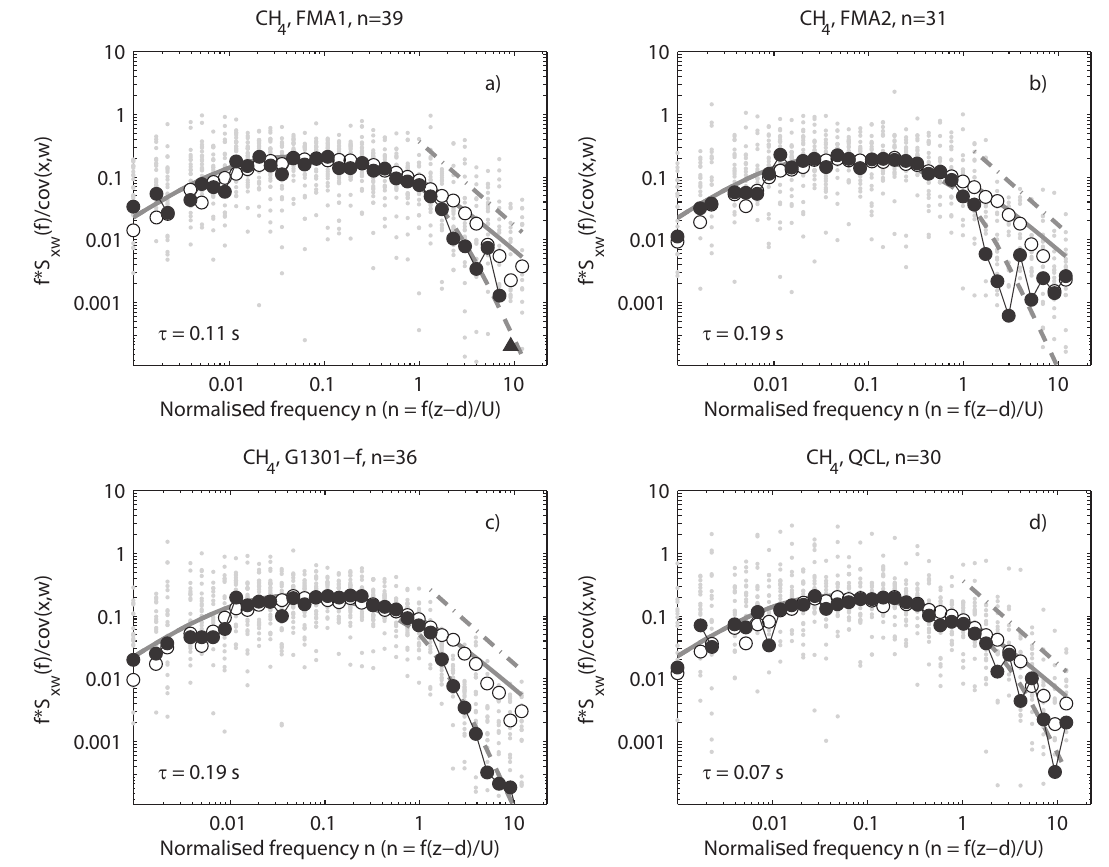
Figure 7. CH 4 cospectra obtained with METEK2. For plot details refer to Fig. 6.